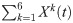
Monthly changes of blogs over 10 years.(A) Each emotional dynamics Zk(t) Tension, Depression, Anger, Vigor, Fatigue, and Confusion are shown from top to bottom. (B) Standardized numbers of summed emotions ∑k=16Xk(t) (top) and the whole number of blogs X(t) (bottom).